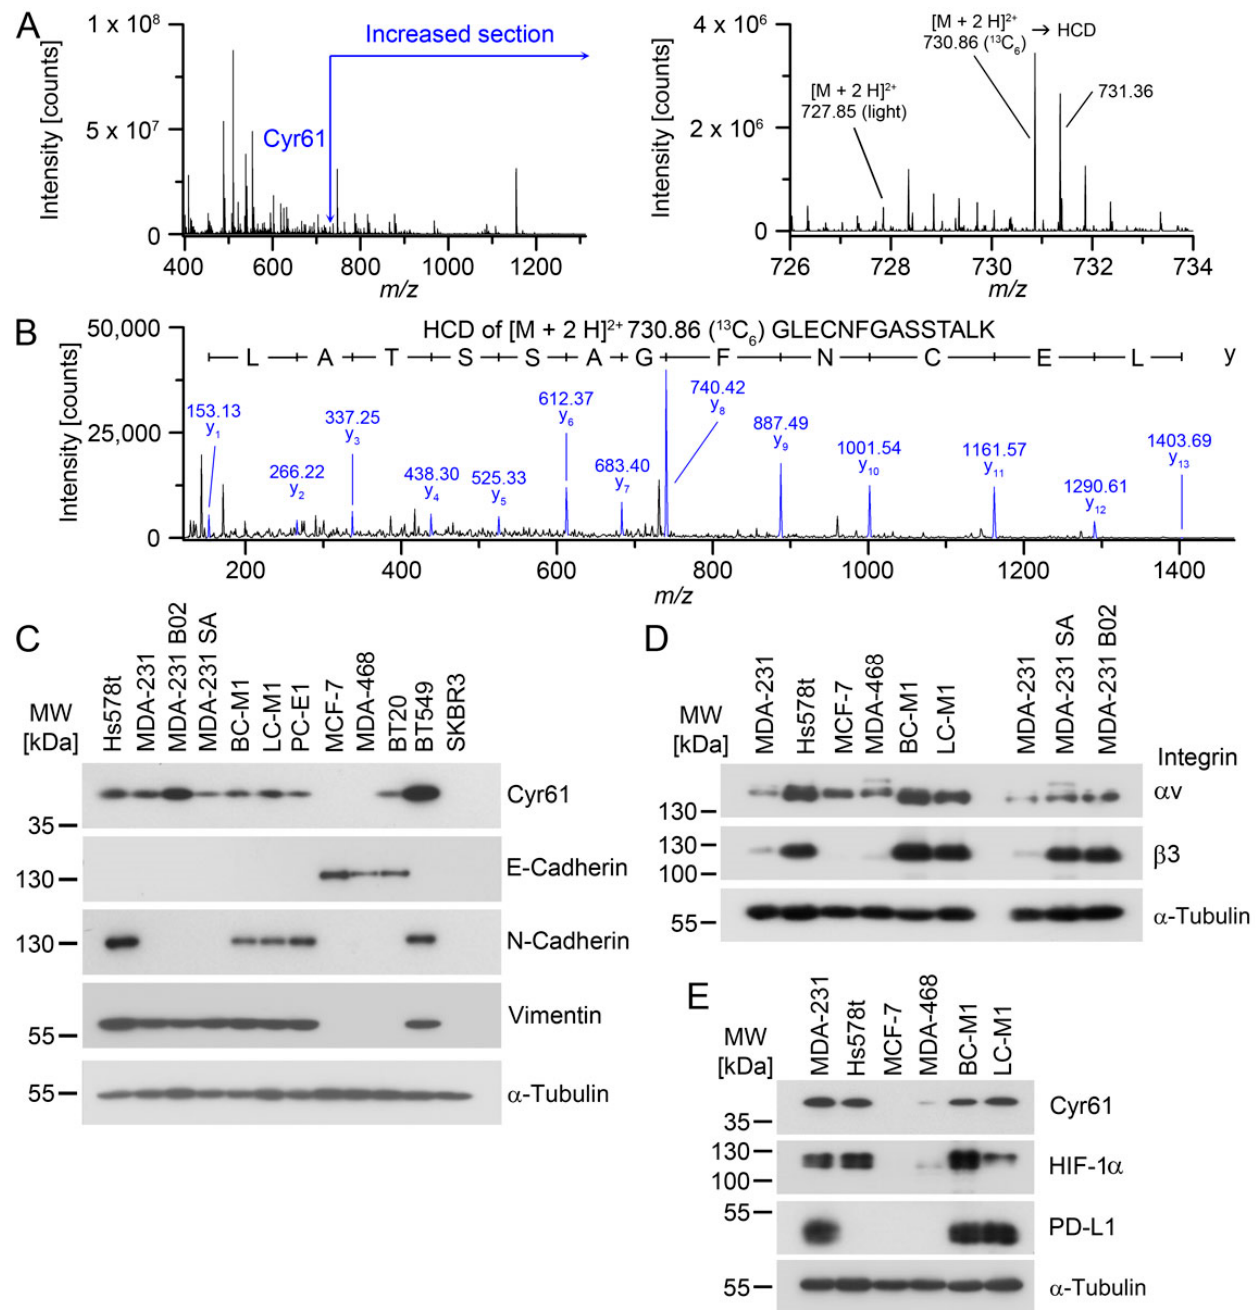
Figure 1. Detection of Cyr61 in tumor cell lines with mesenchymal attributes. ( A ) Detection of Cyr61 by SILAC LC-MS/MS. Left: MS 1 (survey scan) mass spectrum containing the peptides around m/z 731 Da. Right: enlarged section of the Cyr61 peptides containing the light masses from MDA-MB-468 and the 13 C 6 -labelled peptides of BC-M1. ( B ) Positive ion mode HCD (higher-energy collisional dissociation) spectrum of m/z 730.86 [M + 3 H] 3+ Da. The relevant fragments of the y-ion series are assigned with their masses. ( C ) Confirmation of the differential expression of Cyr61 and comparison with the epithelial grade in breast cancer cell lines or DTC cell lines (BC-M1, LC-M1, PC-E1) by Western blot analysis. ( D ) Detection of the integrin species in the breast cancer cell lines by Western blot analysis. ( E ) Comparison of the protein levels of Cyr61, HIF-1 α and PD-L1 in the breast cancer cell lines, as detected by Western blot analysis. ( A , B ) n biol = 4; ( C – E ): n biol = 3. Unlike the other organs, bone marrow exhibits hypoxic areas adjacent to the bone surface even under physiologic conditions, which might be suitable dissemination sites for hypoxia-adapted tumor cells. Therefore, we compared the protein levels of Cyr61